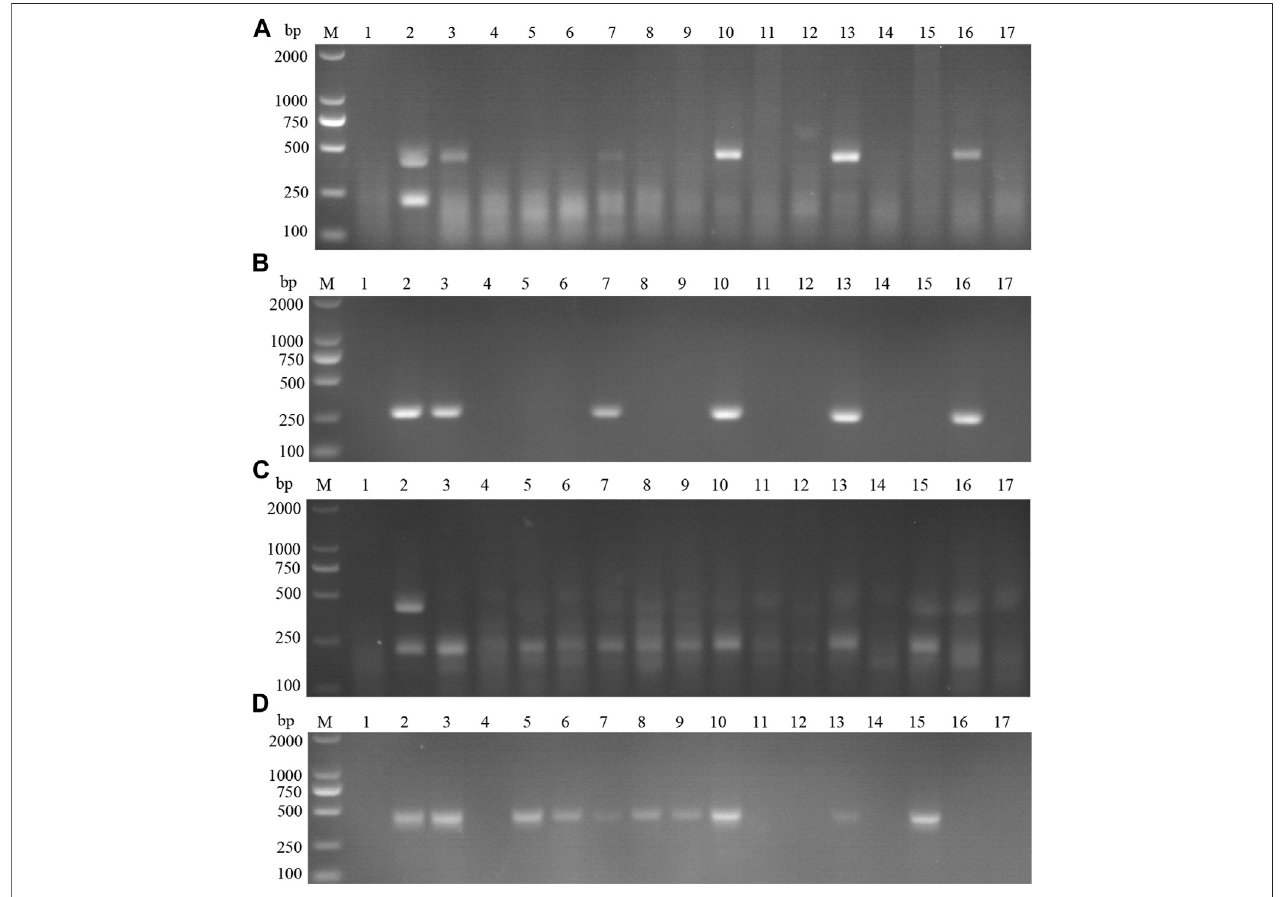
FIGURE14| DetectionofASFVsuspectedclinicalmaterials. (A) TheresultofclinicalsamplesdetectionbydualRAAagarosegelelectrophoresis.M:DL2000 DNA Marker; 1: Negative control; 2: ASFV + CSFV mixed formwork; 3 – 17: ASFV clinical samples. (B) The result of ASFV clinical samples detection by conventional PCR. M: DL2000 DNA Marker; 1: Negative control; 2: ASFV positive template; 3 – 17: ASFV clinical samples. Detection of CSFV suspected clinical materials. (C) The result of clinical samples detection by dual RAA agarose gel electrophoresis. M: DL2000 DNA Marker; 1: Negative control; 2: ASFV + CSFV mixed formwork; 3 – 17: CSFV clinical samples. (D) The result of CSFV clinical samples detection by conventional PCR. M: DL2000 DNA Marker; 1: Negative control; 2: CSFV positive template; 3 – 17: CSFV clinical